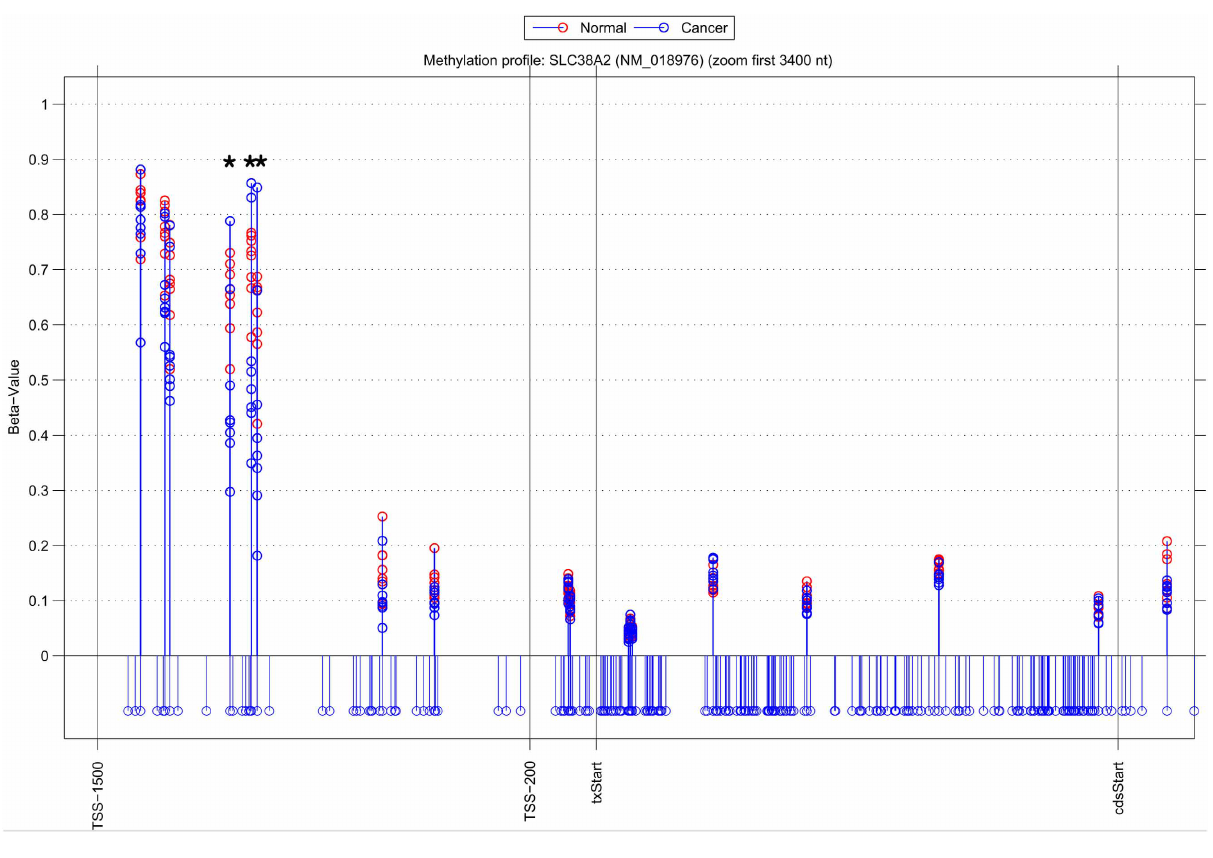
CpG sites identified as differentially methylated by NIMBL [ d = 0 . 1 , m = 2] are highlighted with asterisks. Abbreviations: TSS1500, position 1500bp upstream of transcriptional start site; TSS200, position 200bp upstream of transcriptional start site (txStart); cdsStart, coding sequence